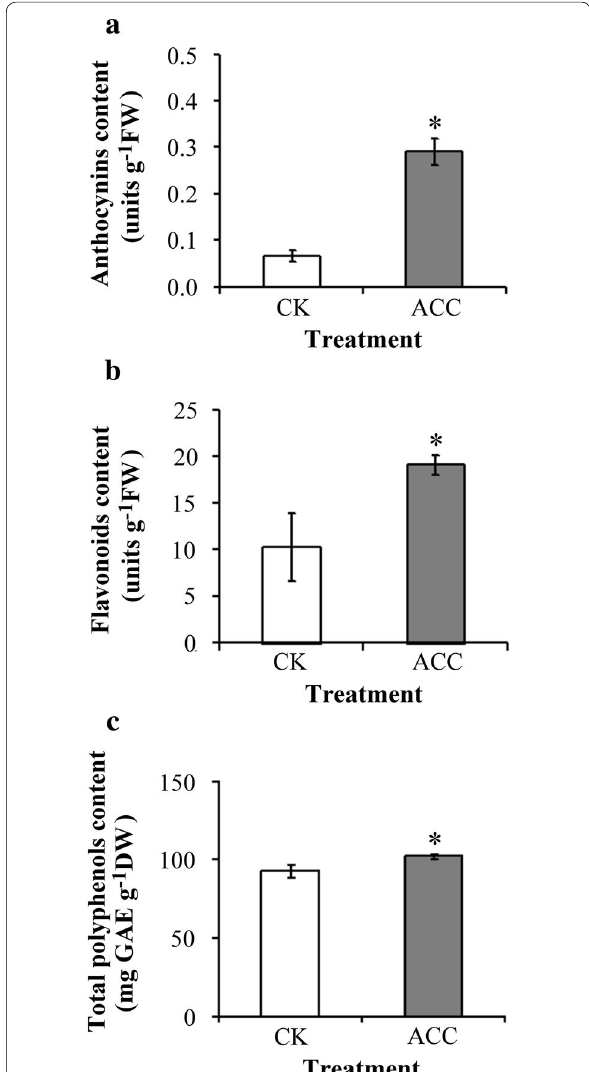
Fig. 2 Effects of ethylene signaling on the content of secondary metabolites in tea seedlings. The content of a anthocyanins, b flavo‑ noids, and c total phenol was determined. Data points are mean of three biologically independent experiments. Asterisks indicate sig‑ nificant differences from the control sample (P < 0.05; Student’s t